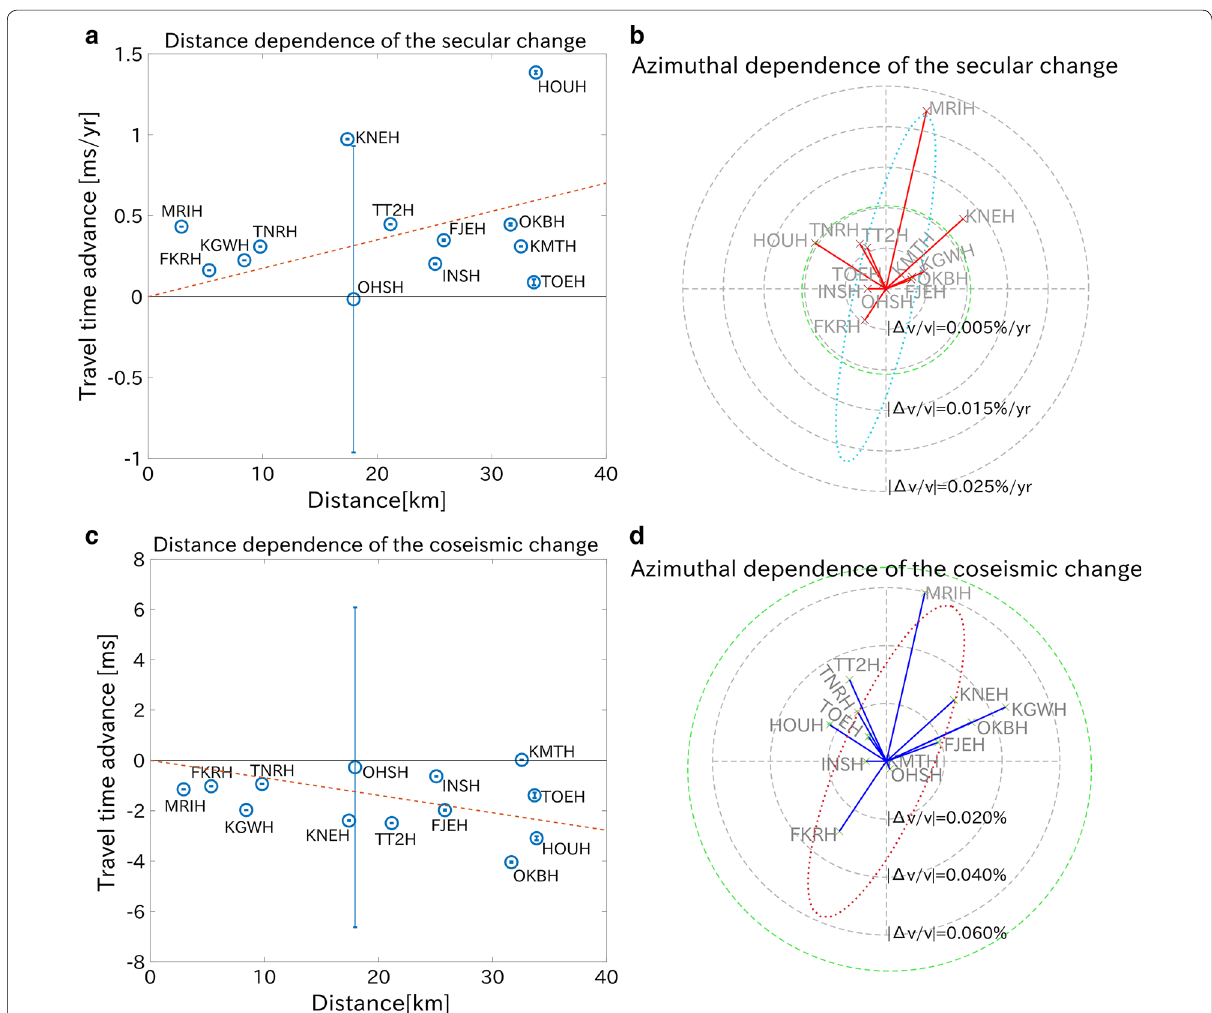
Fig. 5 Distance and azimuthal dependence. Distance dependence ( a , c ) and azimuthal dependence ( b , d ) of coseismic and secular change. In a , c , coseismic steps and rate of secular changes are plotted against distance from the ACROSS source. Yellow broken lines show regression line. In b , d , coseismic steps and rate of secular changes are plotted against the azimuthal direction of the stations with reference to the ACROSS source. Green dashed circles show errors. The distribution of velocity changes for each station is approximated with blue and red ellipse. Travel time change was converted to velocity change using the JMA 2001 travel time